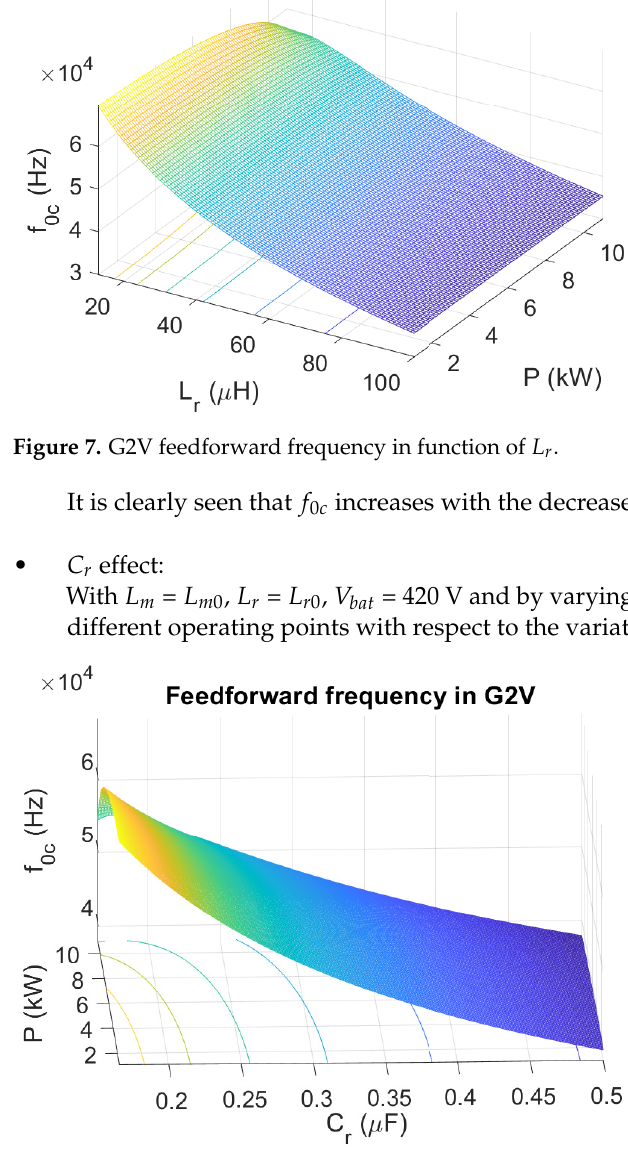
Figure 8. G2V feedforward frequency in function of C r . It is confirmed that f 0 c increases with the decrease in C r too, but at a lower rate than in the case of L r